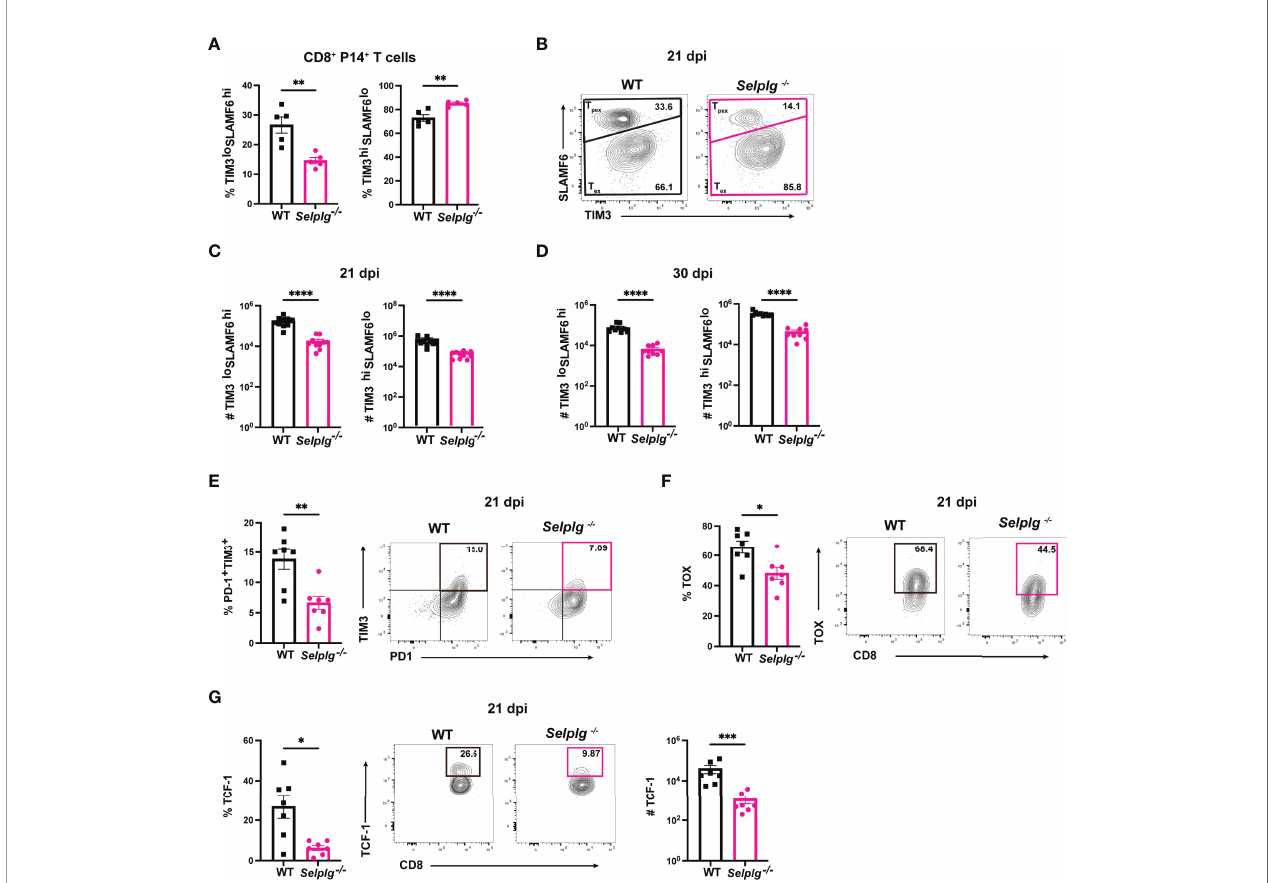
FIGURE 4 | PSGL-1 de fi cient progenitor exhausted CD8 + T cells (Tpex) are decreased during chronic viral infection. Spleens were isolated from Cl13 infected mice at 21 and 30dpi. Frequencies of Tpex and Tex in WT and Selplg -/- P14 + T cells at 21 dpi (A) and representative FACs plots (B) . Numbers of Tpex and Tex of WT and Selplg -/- P14 T cells at 21dpi (C) and 30dpi (D) . Frequencies of PD-1 + TIM3 + (E) , TOX + (F) , and TCF-1 + (G) T cells at 21dpi. **p < 0.01, ****p < 0.001, (unpaired t -test). Data are representative of four independent experiments all with fi ve or more mice per group (error bars, s.e.m.). * < 0.05, *** <